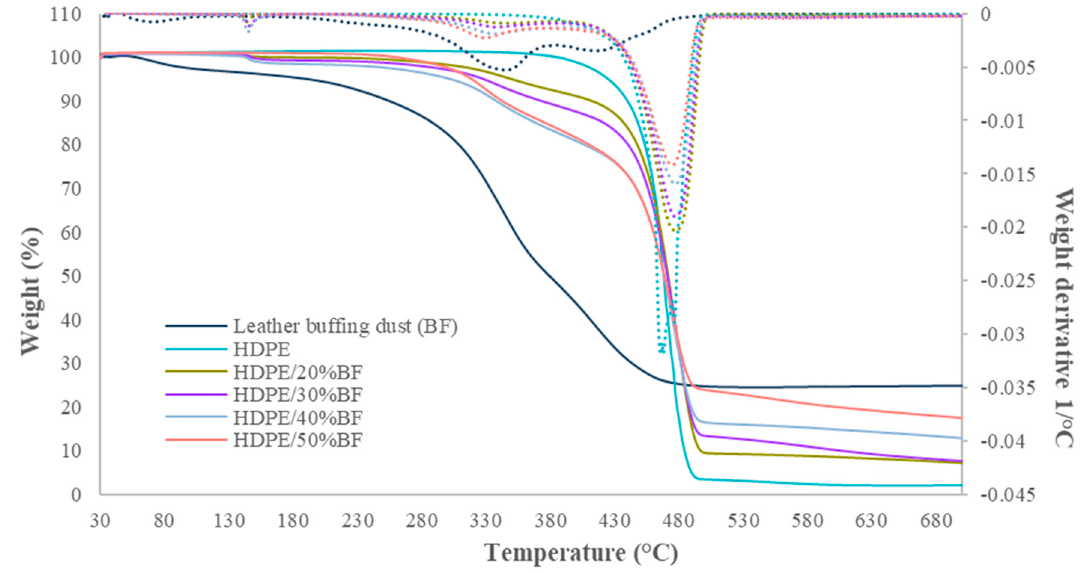
Figure 1. TGA curves and first derivate of TGA curve for neat HDPE, leather waste, and 20 to 50 wt% BF reinforced HDPE composite materials.